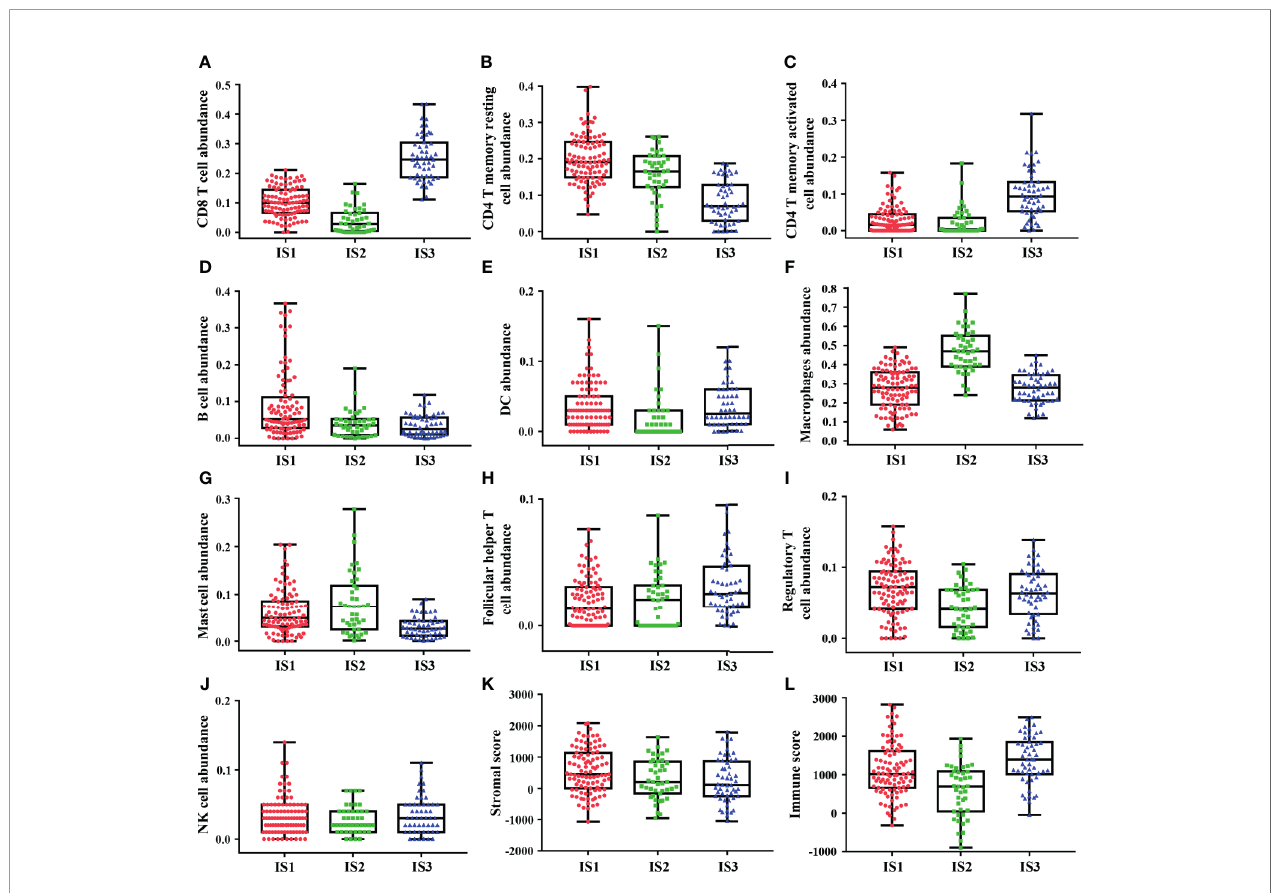
FIGURE 2 | The discovery cohort shows heterogeneity of immune in fi ltration among immune subtypes. Highest abundance of CD8+ T cells, CD4+ T memory activated cells, follicular helper T cells, and NK cells was observed in IS3 (A, C, H, J) , while highest abundance of CD4+ T memory resting cells, B cells, macrophages cells, and mast cells was observed in IS3 (B, D, F, G) . DC cells and regulatory T cells abundance showed one highest and one lowest in IS1 and IS2 (E, I) . Besides, IS3 exhibited the lowest stromal score and highest immune score (K, L) . The plot of patient immune cells abundance shows the median, 25th and 75th percentile values (horizontal bar, bottom, and top bounds of the box), and the highest and lowest values (top and bottom whiskers,